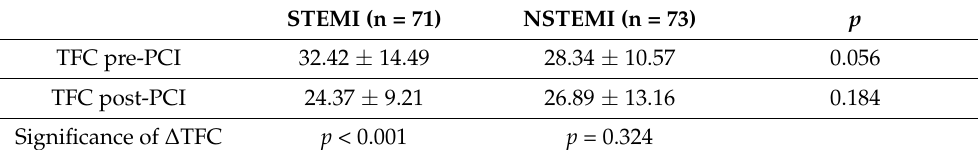
Table 2. Intra- and intergroup comparison of pre- and post-PCI TFCs, both in STEMI and NSTEMI patient.